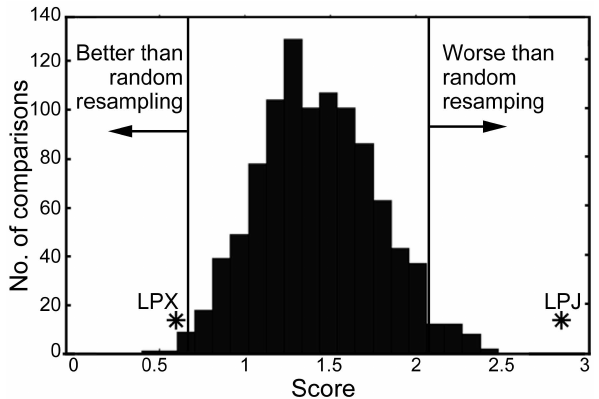
Fig. 2. Results of bootstrap resampling of inter-annual variability in global burnt fraction (1997–2005) from the GFED3 dataset. The asterisks labelled LPX and LPJ show the scores achieved by the LPX and LPJ models respectively. The limits for better than and worse than random resampling are set at two standard deviations away from the mean bootstrapping value (vertical